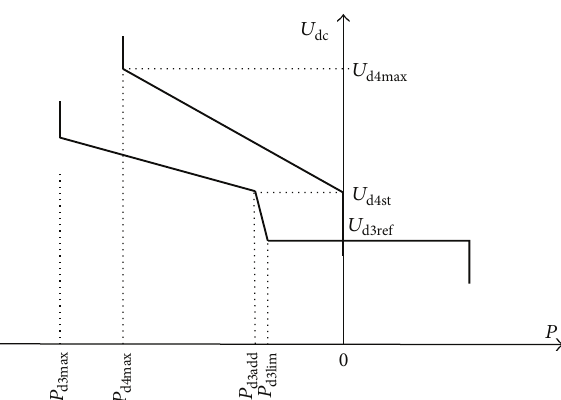
Figure 3: Improved characteristic curve of active power and direct